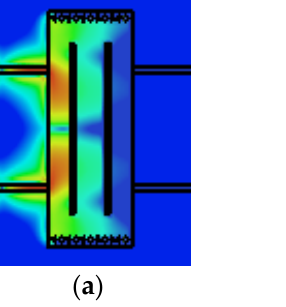
Figure 8. The surface current distributions on the SIW with two slots for CM operating at f 0 . ( a ) The uniform amplitude distributions. ( b ) The vector distributions.